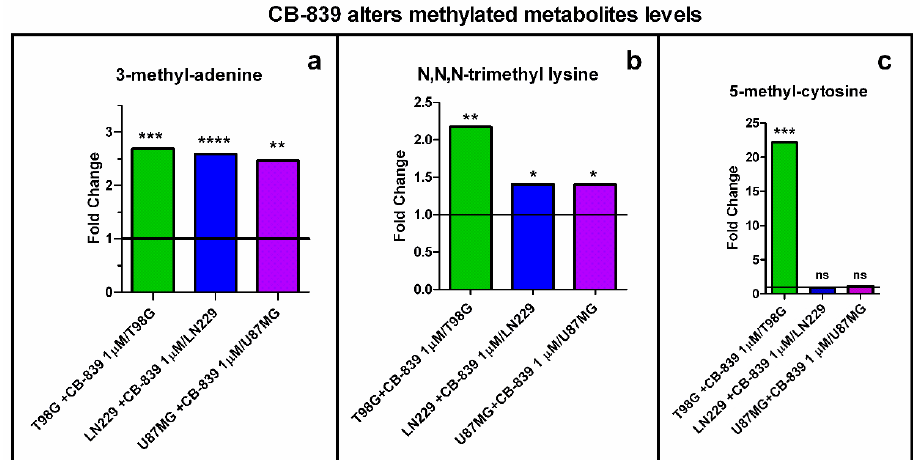
Figure 14. The methylation ratio was significantly increased by treatment with the specific GLS inhibitor CB-839 in the assayed GBM cell lines. Fold change is represented for 3-methyladenine ( a ), N,N,N-trimethyl-lysine ( b ), and 5-methylcytosine ( c ): the last increasing only in T98G. The samples were run in triplicate. For more details, see Section 2. * p < 0.05, ** p < 0.01, *** p < 0.001, **** p < 0.0001.